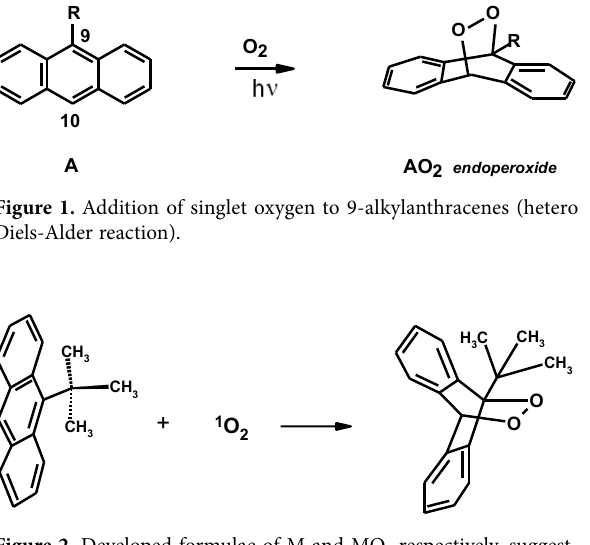
Figure 2. Developed formulae of M and MO 2 respectively, suggest- ing the steric overcrowding due to the tertiobutyl